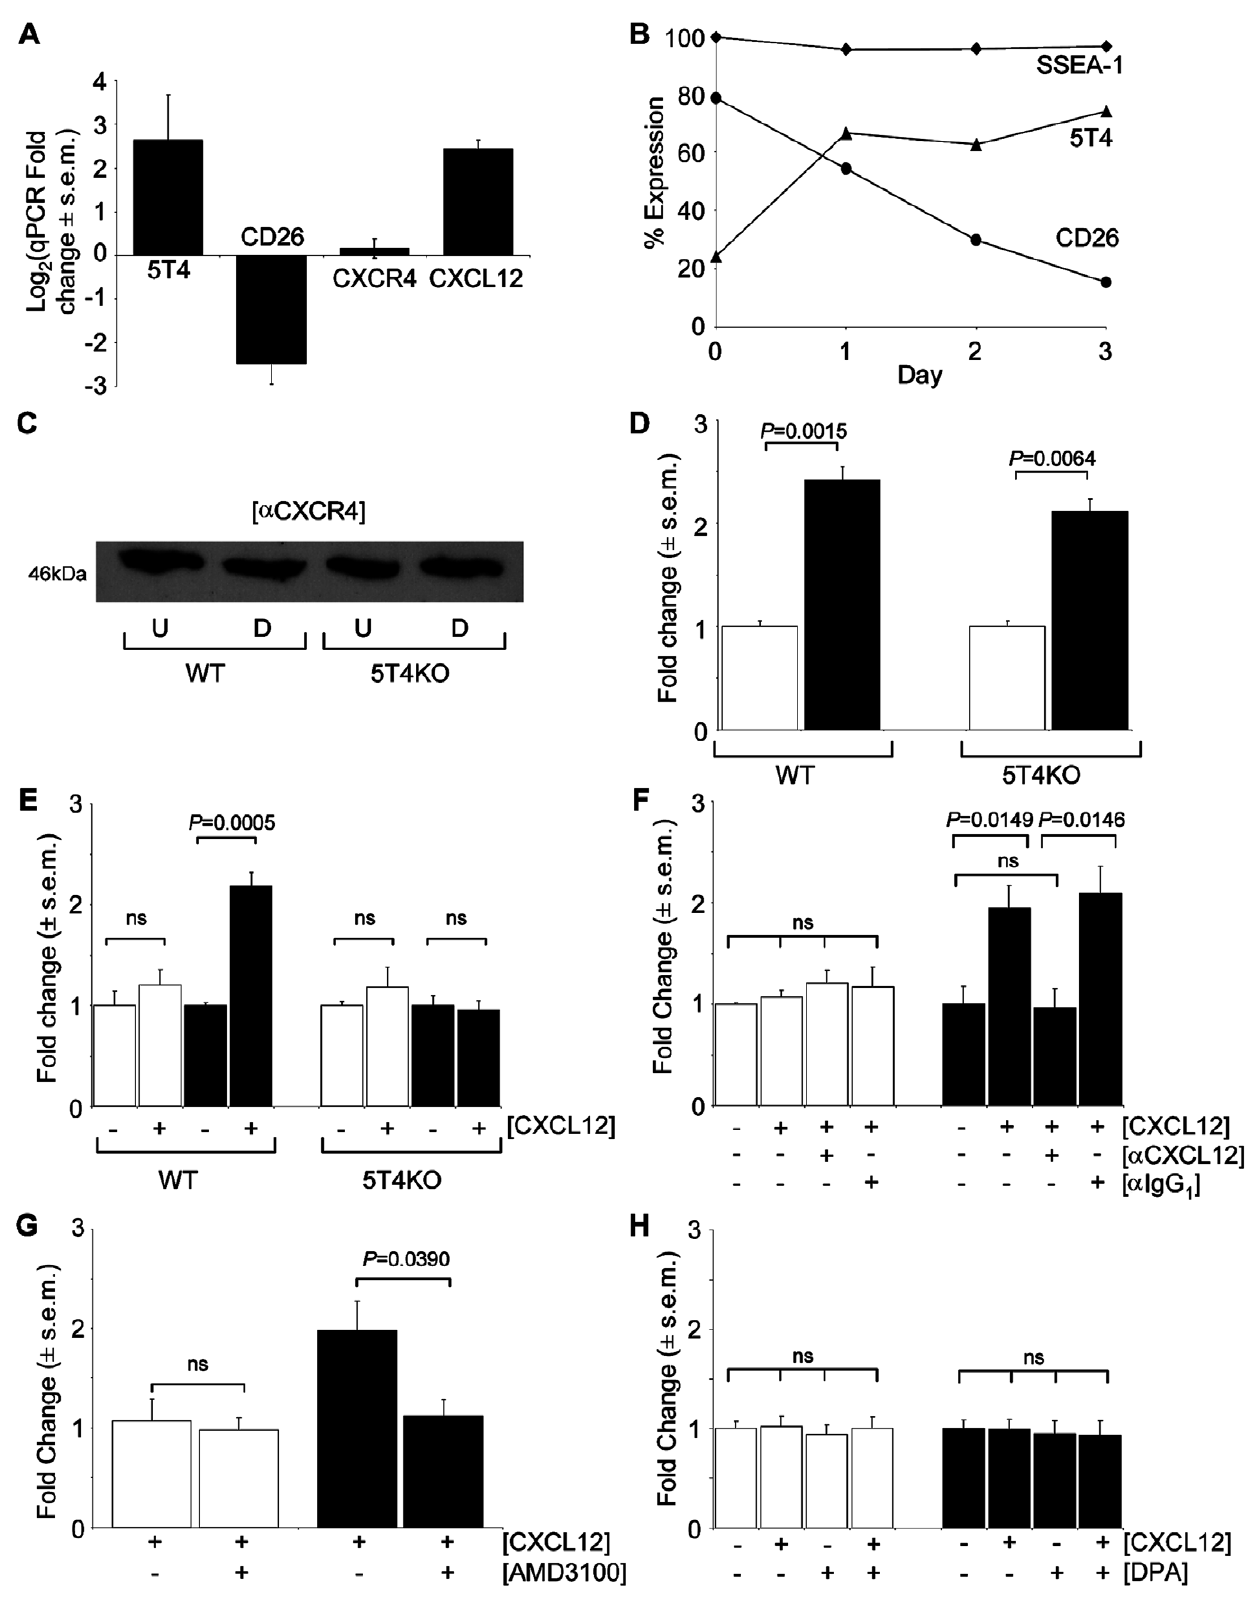
Figure 1. Differentiating mES cells show 5T4 dependent CXCL12 chemotaxis. (A), Triplicate quantitative RT-PCR of WT-ES cells after 3 days differentiation with significant changes in 5T4, CD26 and CXCL12 mRNA but not CXCR4 respectively P =0.014, 0.057, 0.81, 0.012 by Student’s t-test. (B), Flow cytometry analysis of WT-ES cell differentiation 5T4 (triangles), CD26 (circles) and SSEA-1 (diamonds) (n . 3 a single representative time